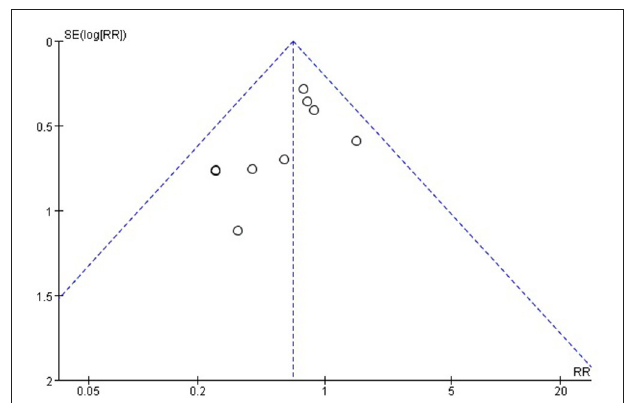
Heterogeneity test ( P < 0.00001, I 2 = 89%) of intraoperative